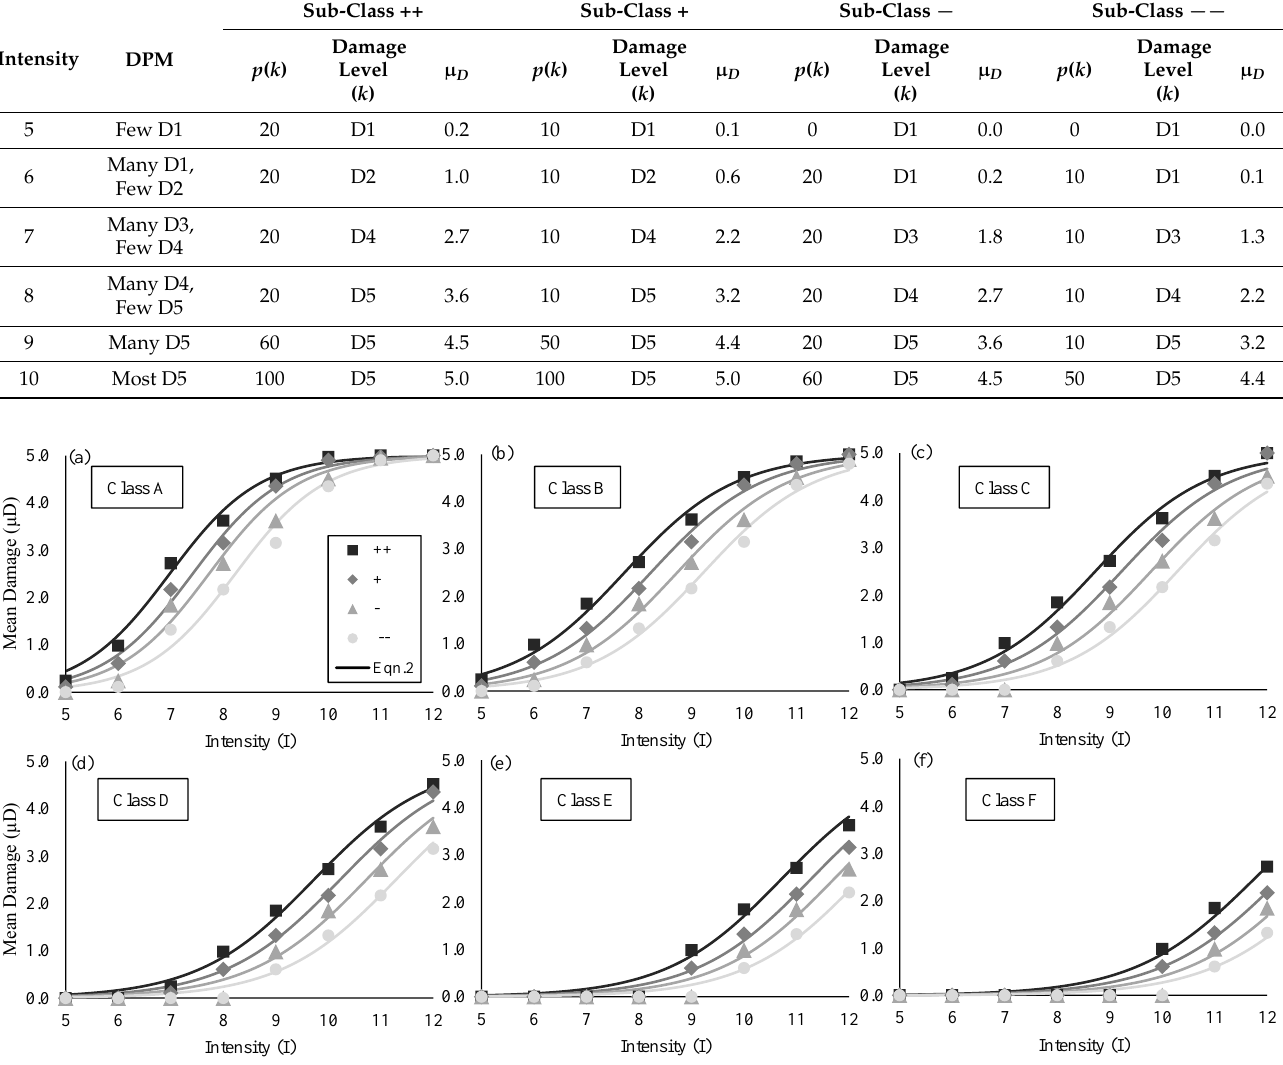
Figure 2. Mean damage vs. earthquake intensity for each vulnerability class and sub-class: ( a ) class A; ( b ) class B; ( c ) class C; ( d ) class D; ( e ) class E; ( f ) class F.